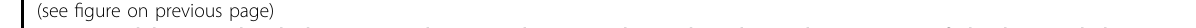
Fig. 2 IM inhibits mitochondrial OXPHOS and increases lactate production by inducing the expression of glycolysis- and pluripotency- related genes. a Schematic diagram of the reprogramming process. b OSKM-transduced MEFs were reseeded in poly- L -lysine-coated 96-well XF plates on D4. On the following day (D5), the medium was replaced with mESC medium and each indicated chemical. After 2 days (D7), the OCR was measured using an XFe96 Flux analyzer. An ATP synthase inhibitor (1.5 μ M oligomycin, ETC complex V inhibitor), uncoupler (5 μ M FCCP), and complex I inhibitor (0.5 μ M rotenone) + complex III inhibitor (0.5 μ M antimycin A) were sequentially added at each indicated time point. c Lactate production was measured in each treatment group on day 7 of reprogramming. d The ATP concentration was quanti fi ed in each treatment group on days 7 (D7) and 10 (D10) of reprogramming. e The expression of the indicated gene in each treatment group was measured using real-time PCR analysis on days 7 and 10 of reprogramming. β -Actin expression was used as an internal control. f ChIP assays were performed on day 7 of reprogramming with or without IM treatment. MEFs and miPSCs were used as negative/positive controls for each histone mark. Histone H3 lysine 4 trimethylation (H3K4me3) and lysine 27 trimethylation (H3K27me3) were precipitated, and the Nanog and Oct4 promoter loci were determined by real-time PCR. Input samples were used as a relative control. * p < 0.05; ** p < 0.01; *** p < 0.001 (Student ’ s t